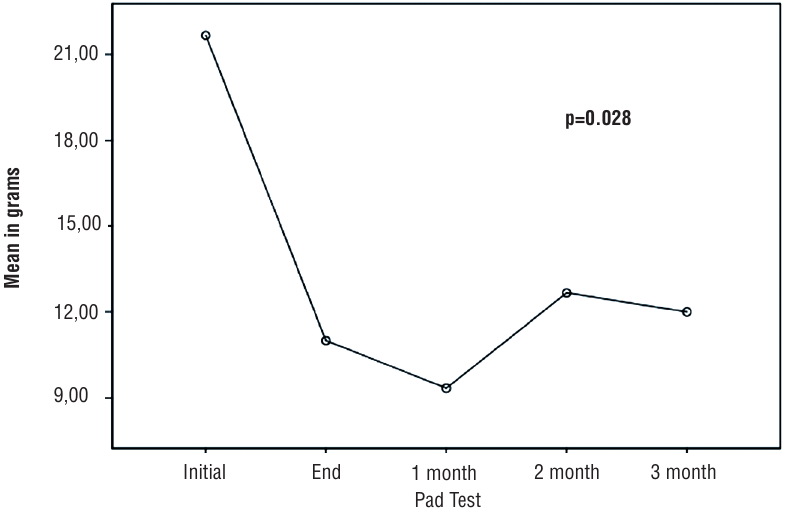
Figure 3 - Comparison of mean urinary loss in grams (g) Pad Test at the begginning-, end-, and after one-, two- and three months of